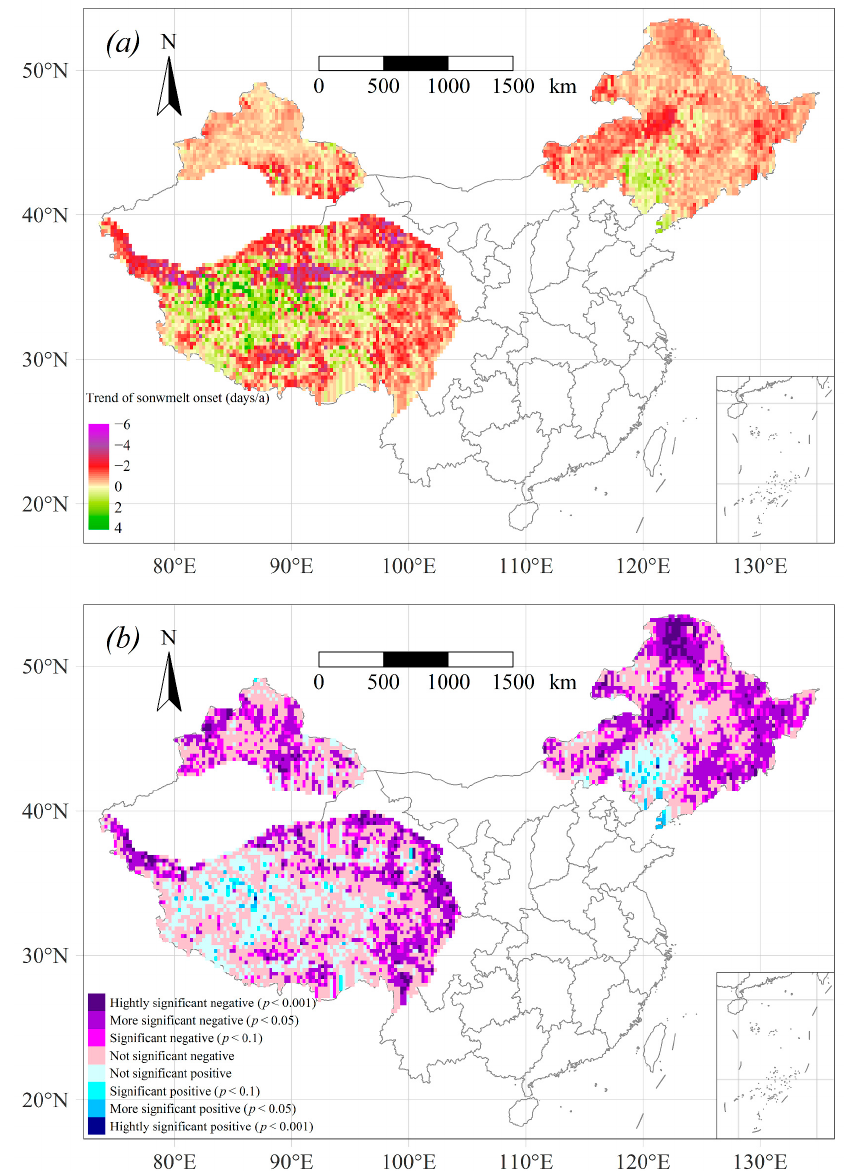
Figure 6. Trends of the snowmelt onset day over the past 40 years (1981–2020) across China’s three stable snow cover regions. ( a ) Spatial distributions of the decadal trends and ( b ) their corresponding significance levels (deep purple and deep blue ( p < 0.001), purple and blue ( p < 0.05), light purple and light blue ( p < 0.01)). The unit days/a refers to days per year.